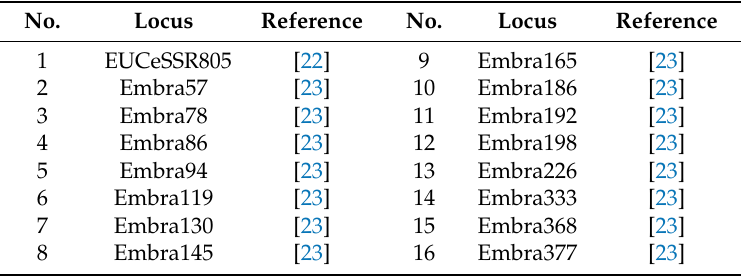
Table 3. Details of 16 microsatellite loci examined in this